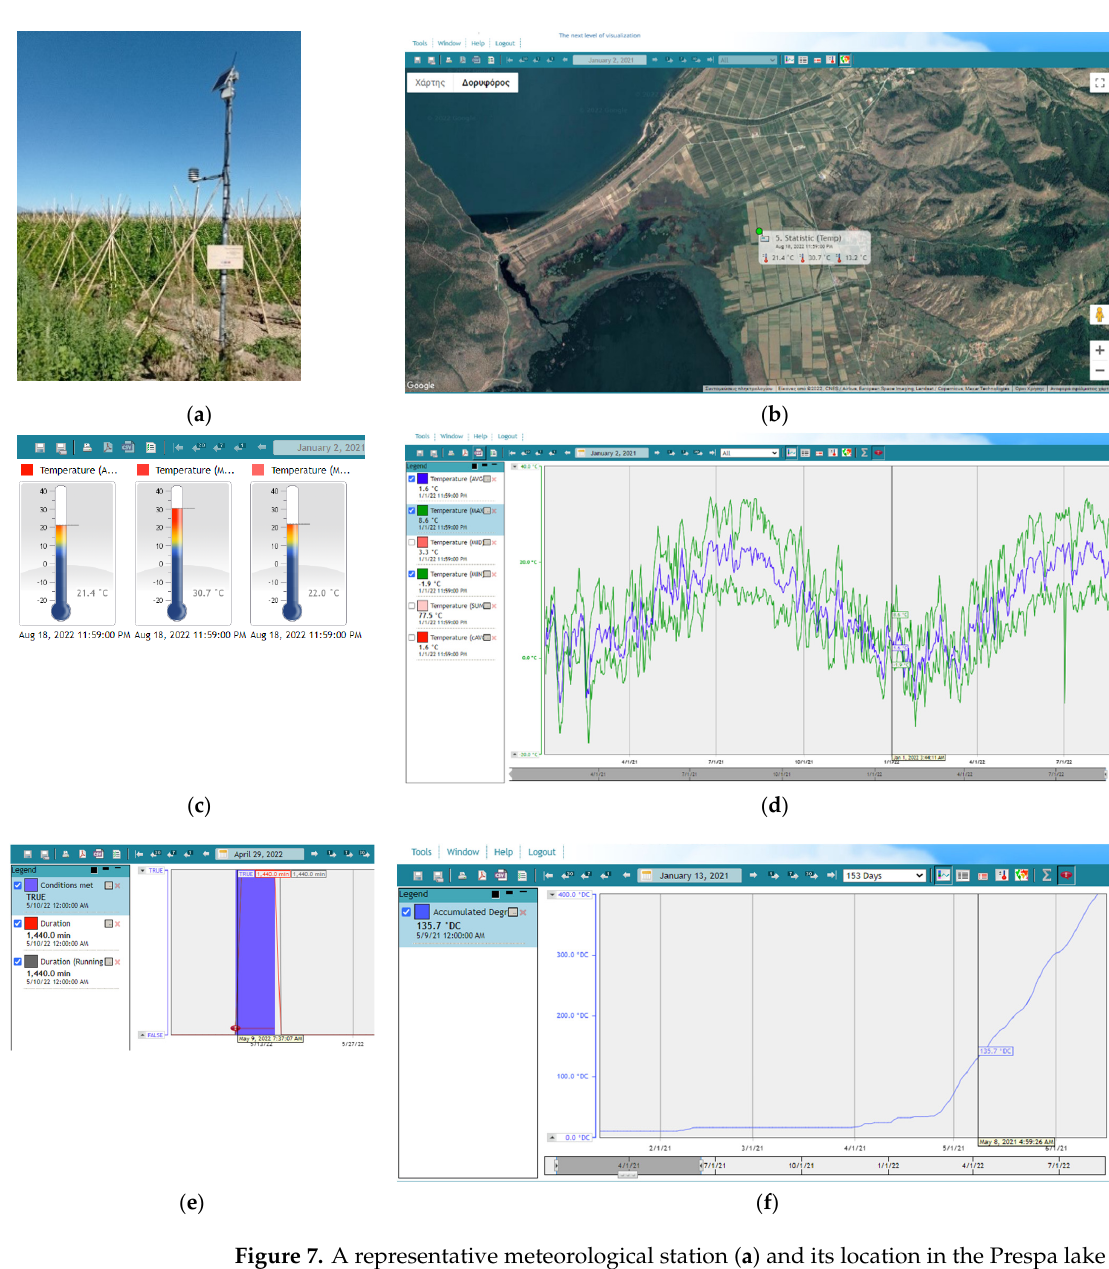
Figure 7. A representative meteorological station ( a ) and its location in the Prespa lake area in the prefecture of Florina ( b ). Graphical User Interface (GUI) and real time software outputs of: mean, max and min temperature online sensor indications ( c ), mean (blue), max and min (green) daily temperature recordings (1 January 2021 so far) ( d ), pest risk thresholds indications and their duration for the first flight of H. armigera ( e ) and accumulated degree ‐ days from 1 January 2021 ( f ).